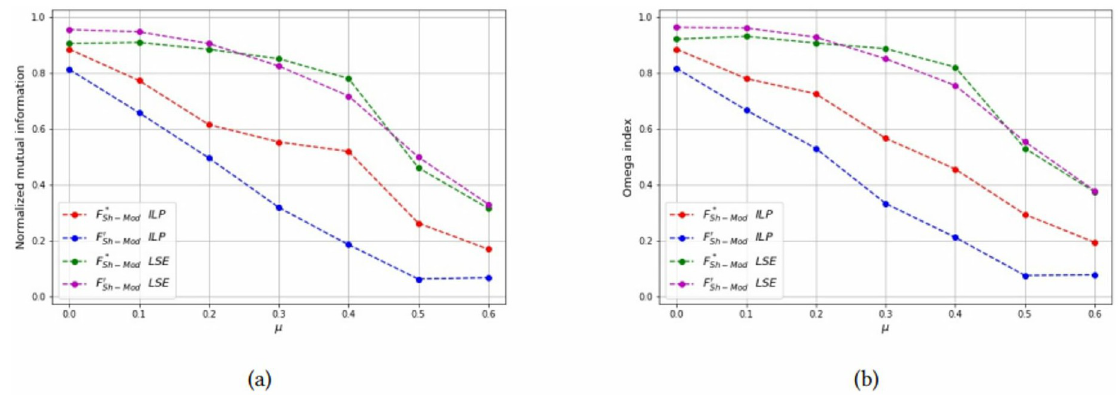
Fig 13. Test results on non-overlapping communities, parameters N = 40, n Omega for each solution